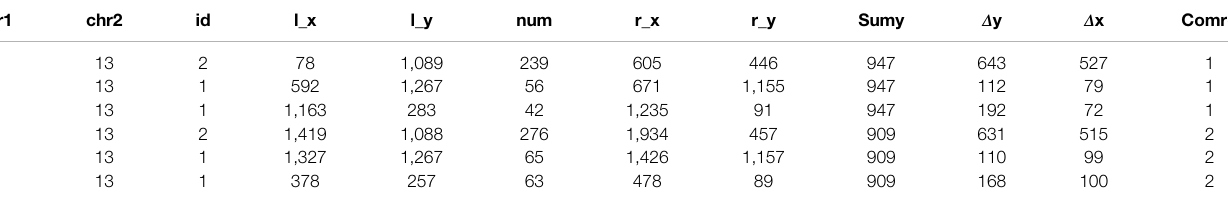
TABLE 3 | Vitis vinifera Chr. 13 result.csv fi le.